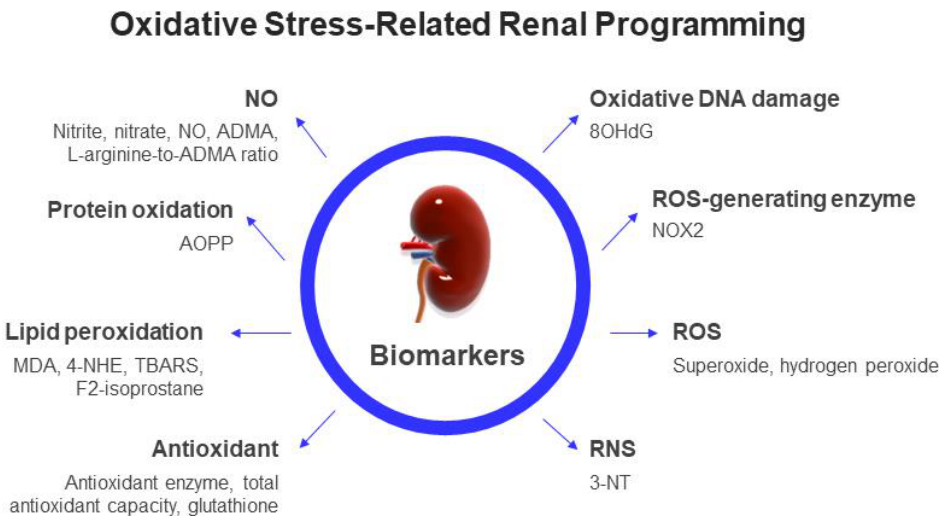
Figure 2. Schema summarizing the potential biomarkers regarding oxidative-stress-related renal programming in clinical and experimental studies. NO: nitric oxide; ADMA: asymmetric dimethylarginine; AOPPs: advanced oxidation protein products; 4-HNE: 4-hydroxy-2-nonenal; MDA: malondialdehyde; TBARS: thiobarbituric acid; 8-OHdG: 8-hydroxy- 2′ -deoxyguanosine; 3-NT: 3-nitrotyrosine.